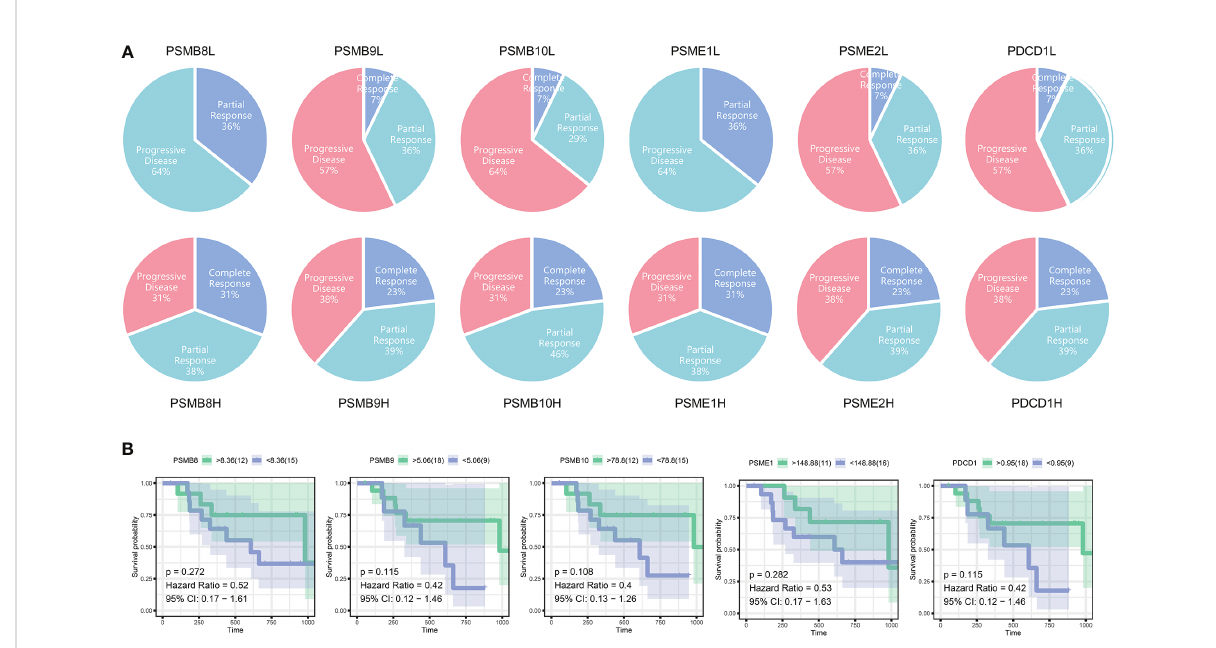
FIGURE 6 (A) The immunotherapy outcomes in GSE78220. (B) Survival analysis of different subunit genes of immune proteasome in cutaneous malignant